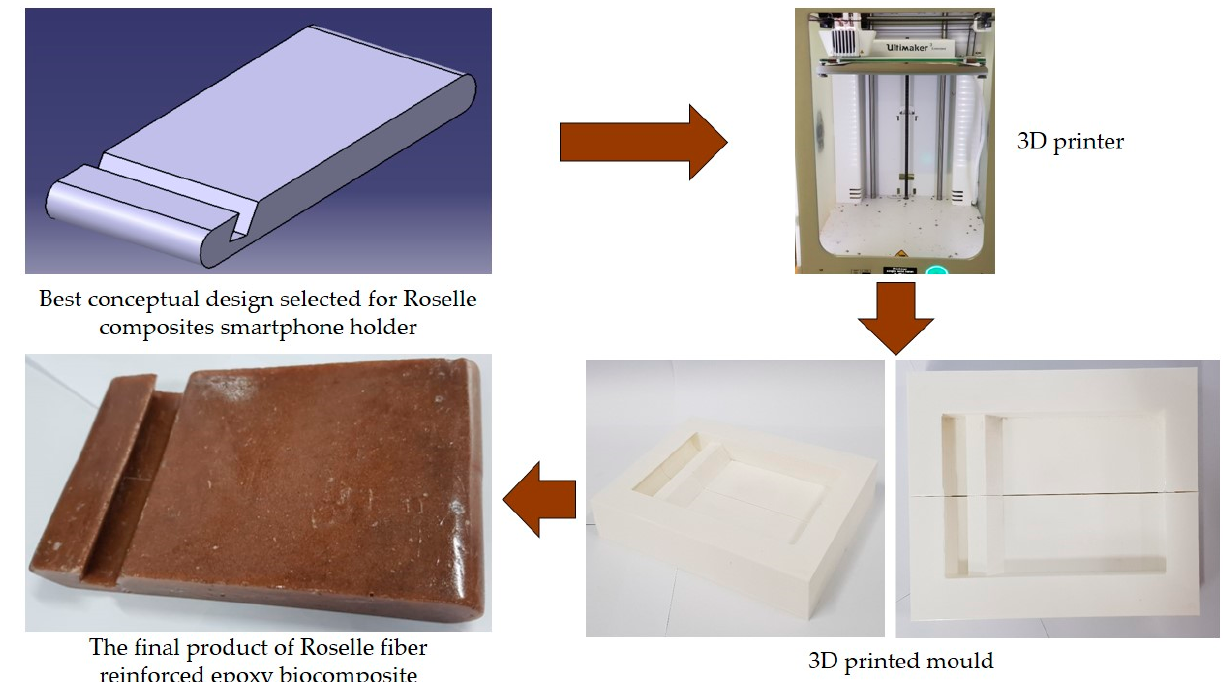
Figure 6. Smartphone holder using roselle fiber-reinforced polymer composites.